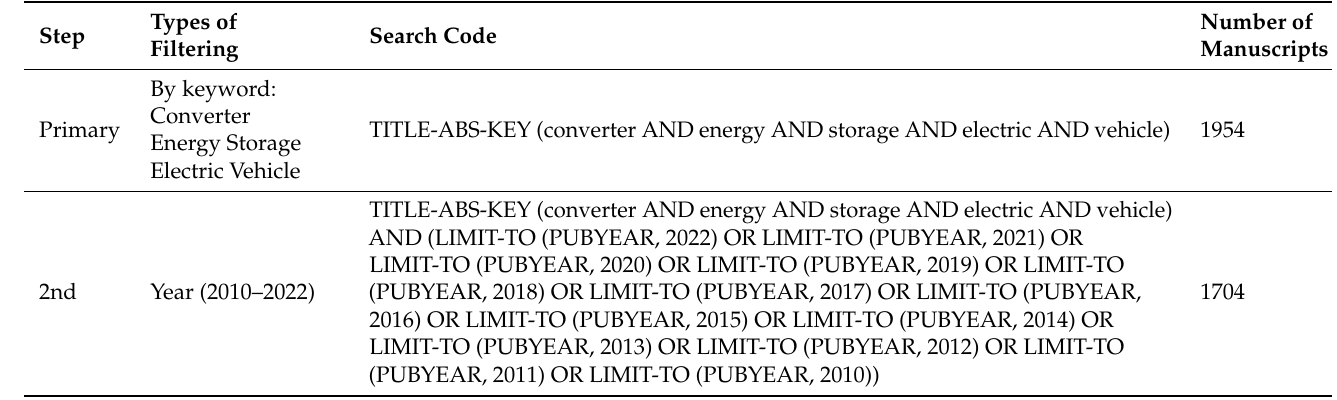
Figure 2. Manuscript’s selection stages from Scopus database. Table 2. Searching codes to find the most relevant 100 manuscripts from the Scopus